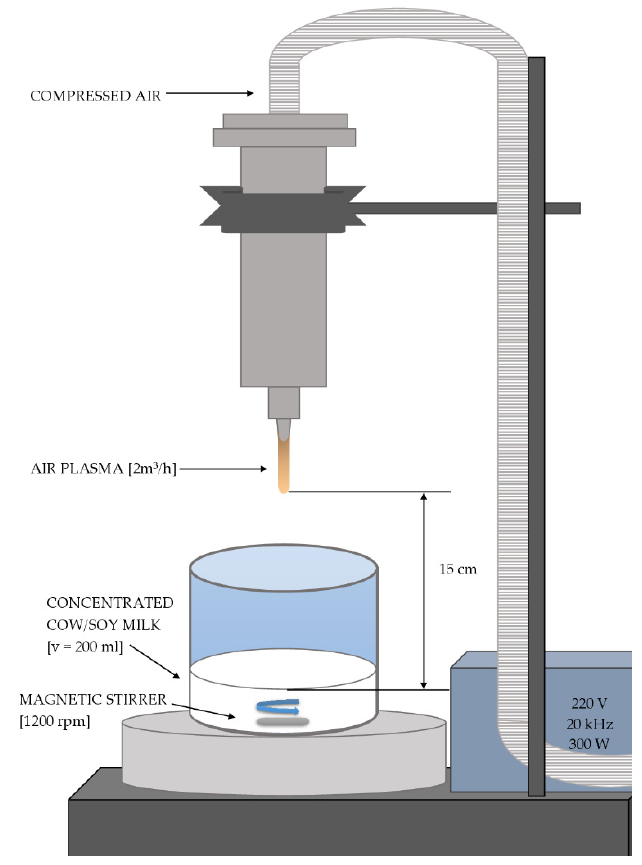
Figure 1. Scheme of cow/soy milk treatment with plasma jet system. Plasma treatment was carried out until the pH of the samples was 6.00 ± 0.02. Then, all portions were lyophilized using a freeze dryer (ChristAlpha 2-4 LSC plus model, Osterode am Harz, Germany) according to the method described in the study by Marcinkowska-Lesiak et al. [24]. Finally, lyophilizates were ground using a mortar and passed through a vibrating sieve (RetschGmbK, Hann, Germany) with a mesh size of 425 µ m. The residual nitrite content in obtained powders was analyzed according to the method of Lee et al. [30] (described in Section 2.4). The above process was performed in triplicate. The mean nitrite content in the plasma-treated cow and soy milk powders was 1317.78 ± 138.17 mg/kg and 2642.55 ± 221.66 mg/kg, respectively. Before use, both curing agents were packaged under vacuum in polyamide/polyethylene pouches and stored at − 60 ◦